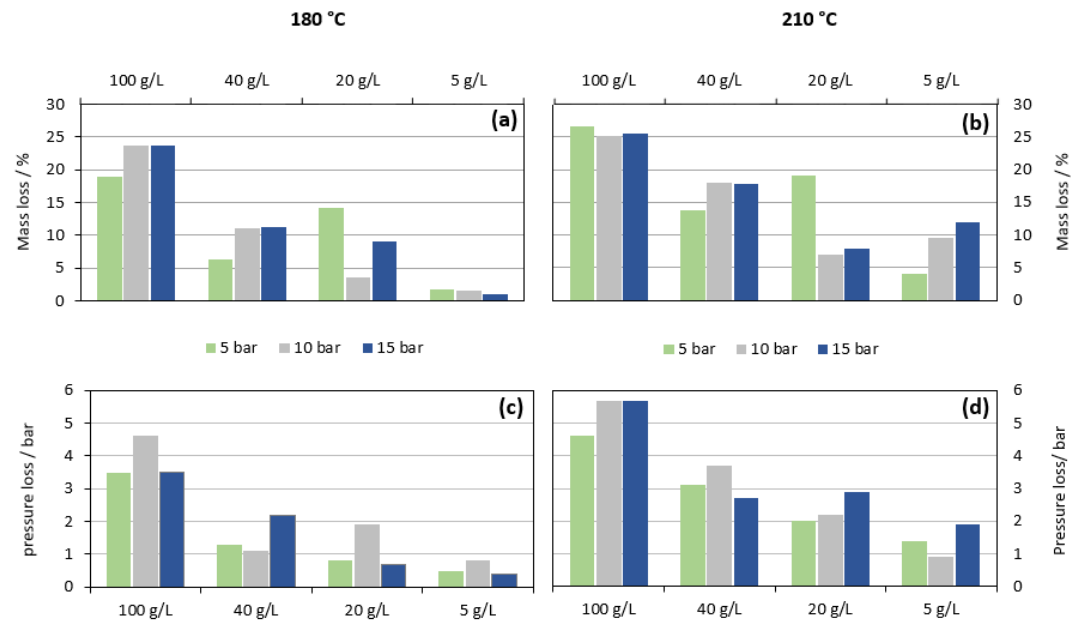
Figure 6. The mass loss at 180 °C/series A2 ( a ); the mass loss at 210 °C/series A1 ( b ); the pressure loss at 180 °C/series A2 ( c ); the pressure loss at 210 °C/series A1 ( d ); constants: 1 h, 800 rpm, S/L: 0.1.